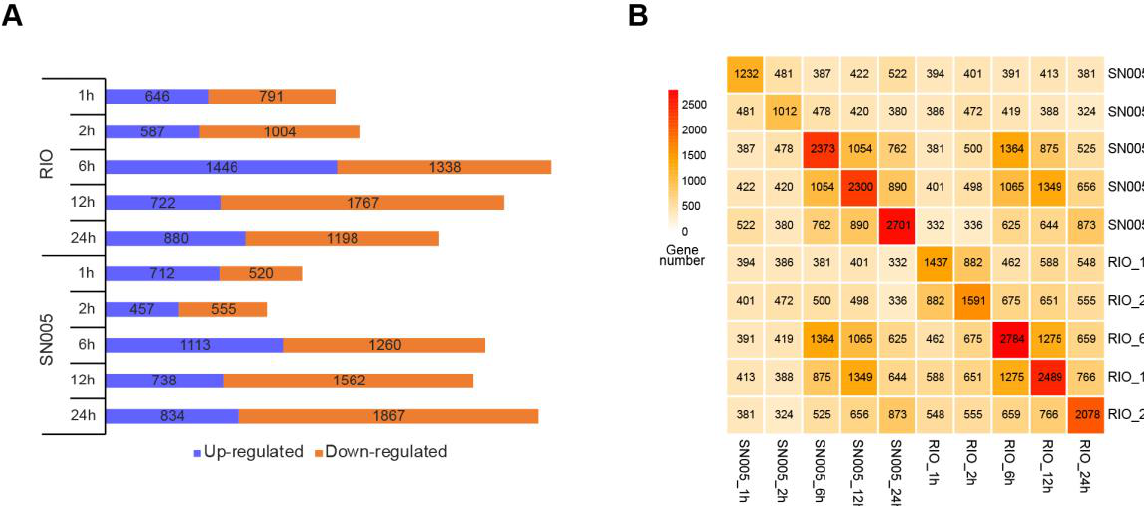
Figure 2. Overview of differentially expressed genes (DEGs) in the tolerant line RIO and the sensitive line SN005 after salt treatment. ( A ) Number of upregulated and downregulated DEGs in the two genotypes at each time point. ( B ) The number of overlapping DEGs between different genotypes at different time points. The colors of heatmap cells indicate the number of DEGs. The number in heatmap cells indicates the number of overlapping DEGs between DEGs set in the horizontal axis and vertical axis.